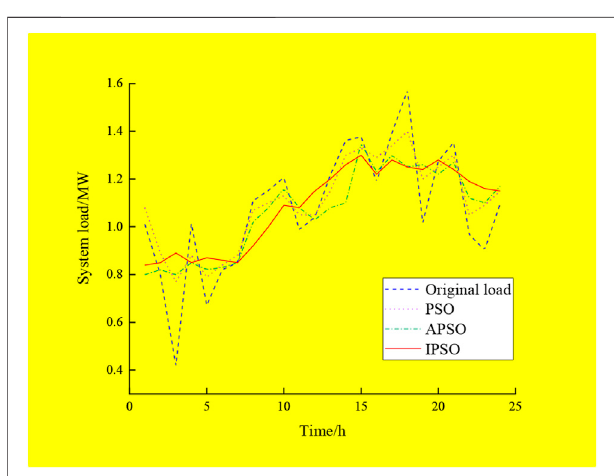
FIGURE 6 | Curve of the original and optimized daily load.